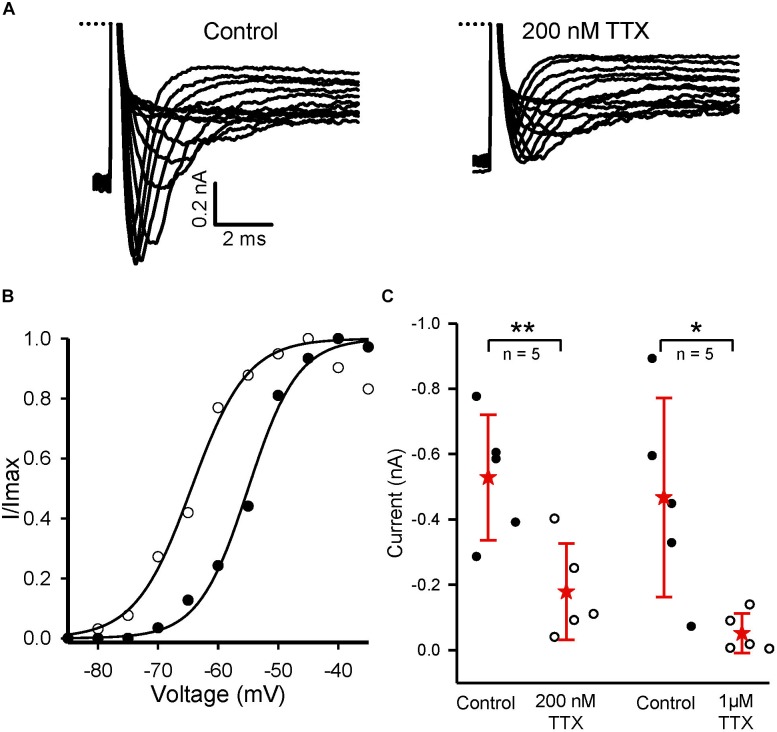
TTX-insensitive current is present in crista hair cells at early postnatal ages. (A) Control INa and currents in the presence of 200 nM TTX in a dissociated P5 hair cell in response to a series of voltage steps in 5 mV increments from –104 to –34 mV. (B) The activation curve for INa shifts to the left in 200 nm TTX (same cell as A, filled circles control, unfilled circles 200 nM TTX) indicating a more negative activation range for the TTX-insensitive current. (C) Mean reduction of inward current in 200 nM TTX for five pup hair cells (P5–9). Current decreased from a mean value of –0.53 (0.19) nA to –0.18 (0.15) nA, n = 5, P = 0.002, paired t-test. In 1 μM TTX, current decreased from –0.47 nA (0.3) nA to –0.052 (0.06) nA in five hair cells, all P5 (P = 0.038, paired t-test). ∗∗P < 0.01, ∗P < 0.05. Peak inward current was measured at the –50 mV step in eight cells, and at –45 or –30 mV in the remaining hair cells. External solution was L-15; electrode solution was Cs+-based.